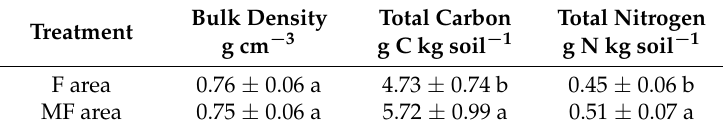
Table 1. Soil bulk density, total carbon, and nitrogen content in top 0–30 cm soil in chemical fertilizer treatment (F) area and combined manure and chemical fertilizer treatment (MF) area just before renovation. Values are mean ± standard deviation. Same letters besides the values denote no significant difference between F area and MF area ( p <